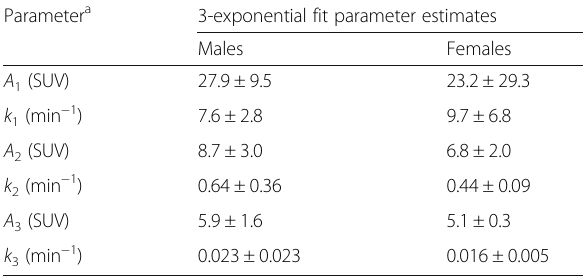
Table 1 Pharmacokinetics of 18 F-TFB in healthy